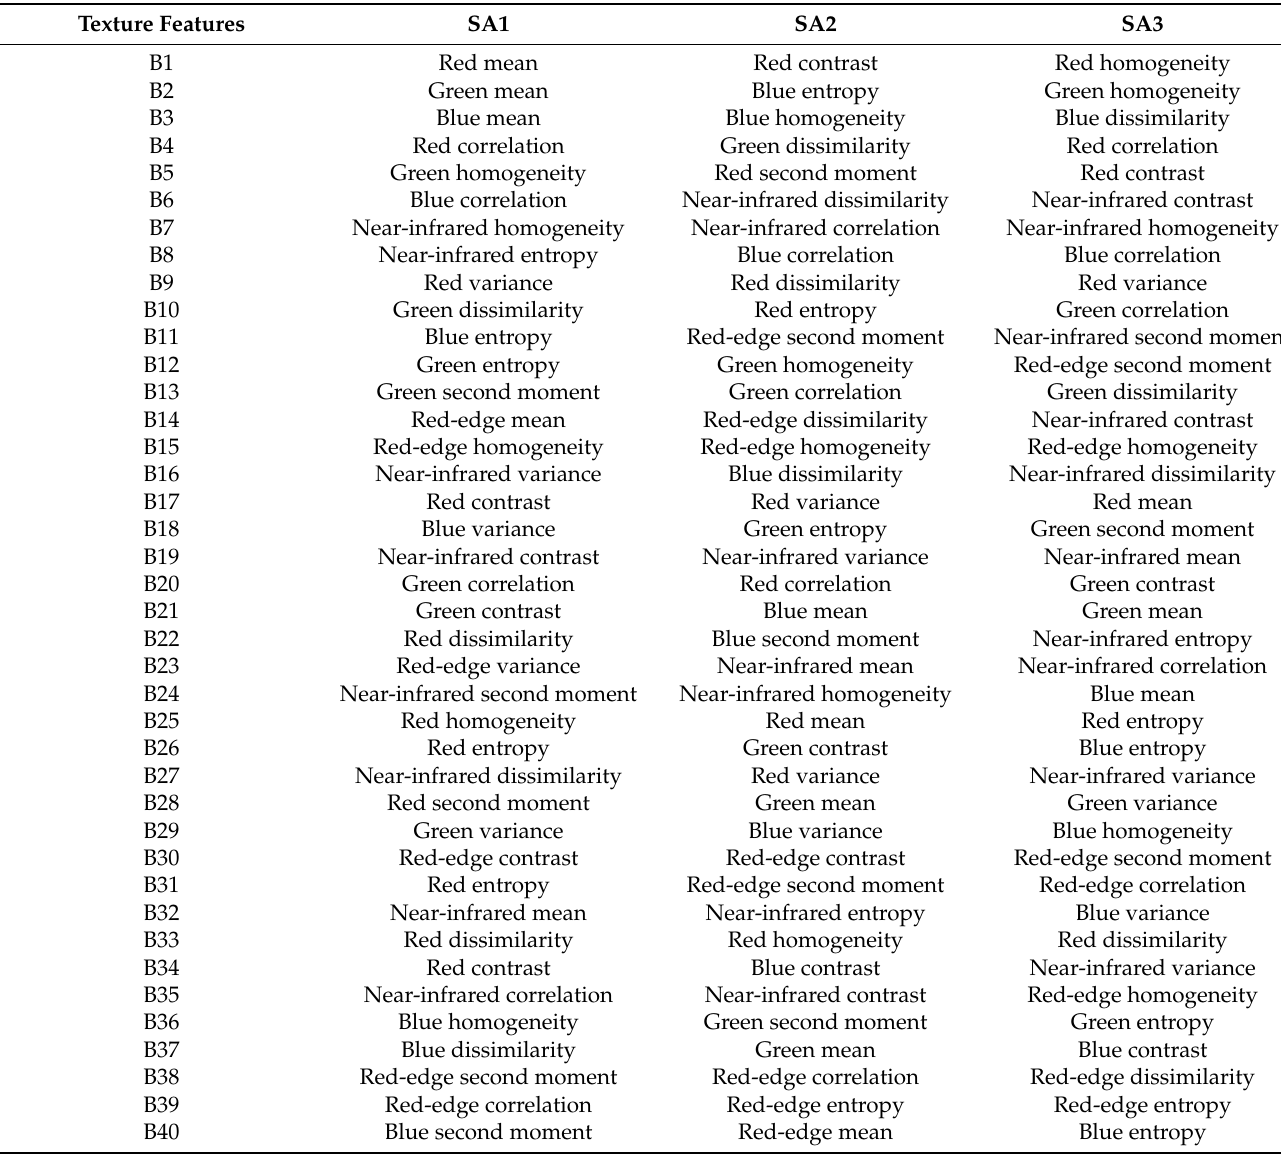
Table A3. The importance ranking of the texture